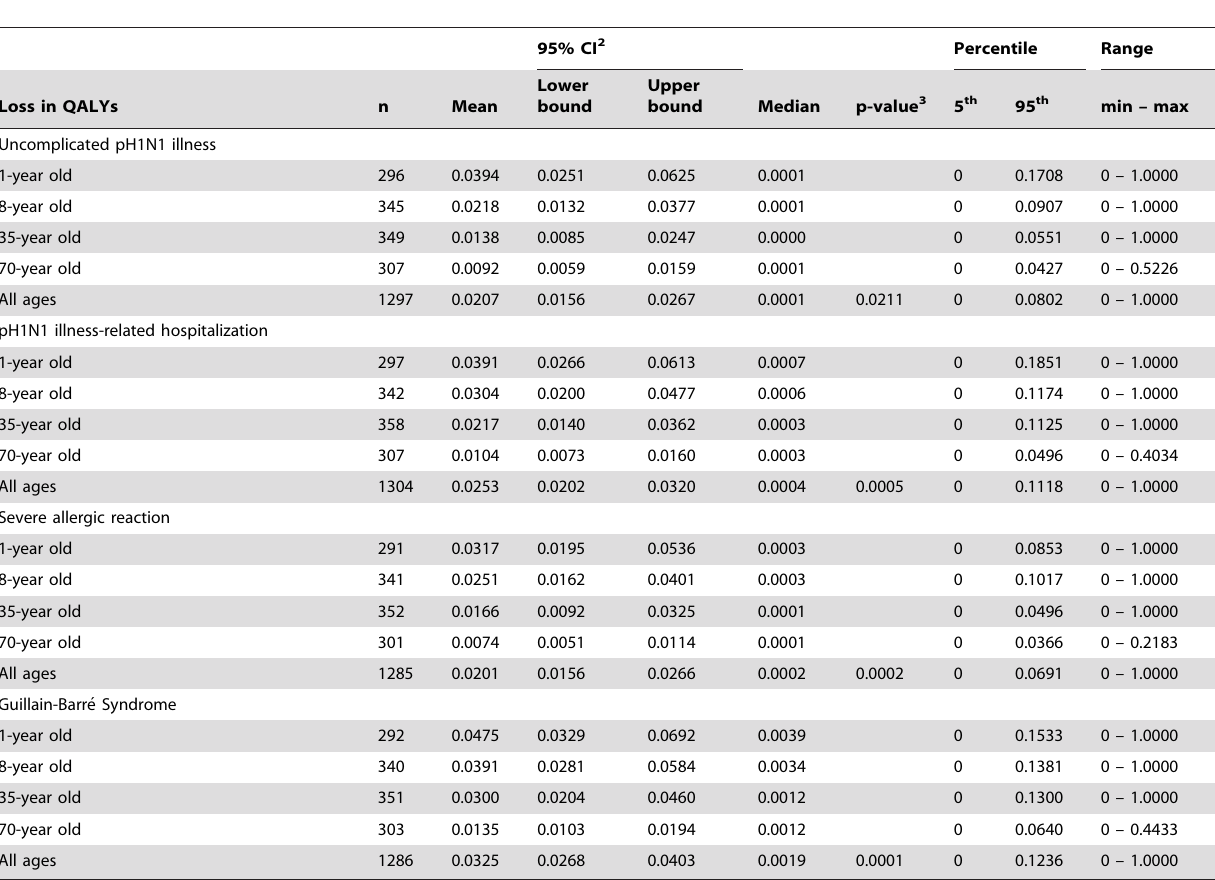
Table 4. Loss in quality adjusted life years (QALYs) for 2009 pandemic influenza (A) H1N1 illness and vaccination-related adverse events 1